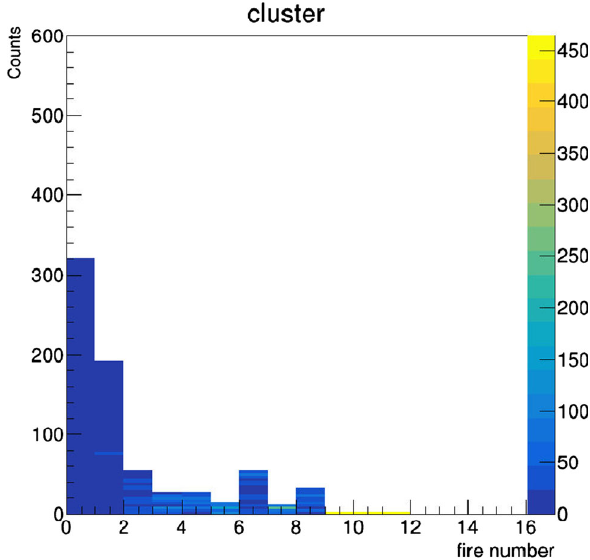
Fig. 9 Clustersize of the MRPC in hardon in-beam